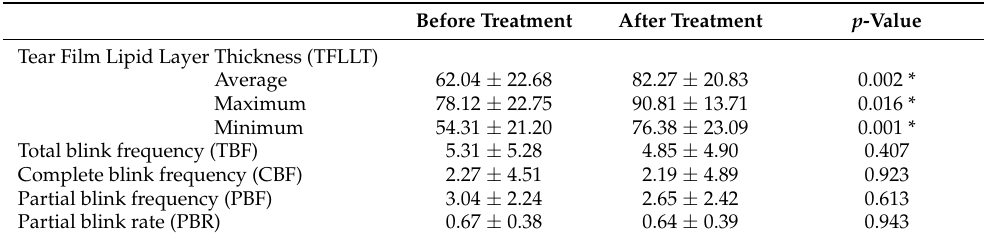
Table 2. Tear film lipid layer thickness and interferometer-derived parameters before and after warm compression treatment. (Analysis with the entire data